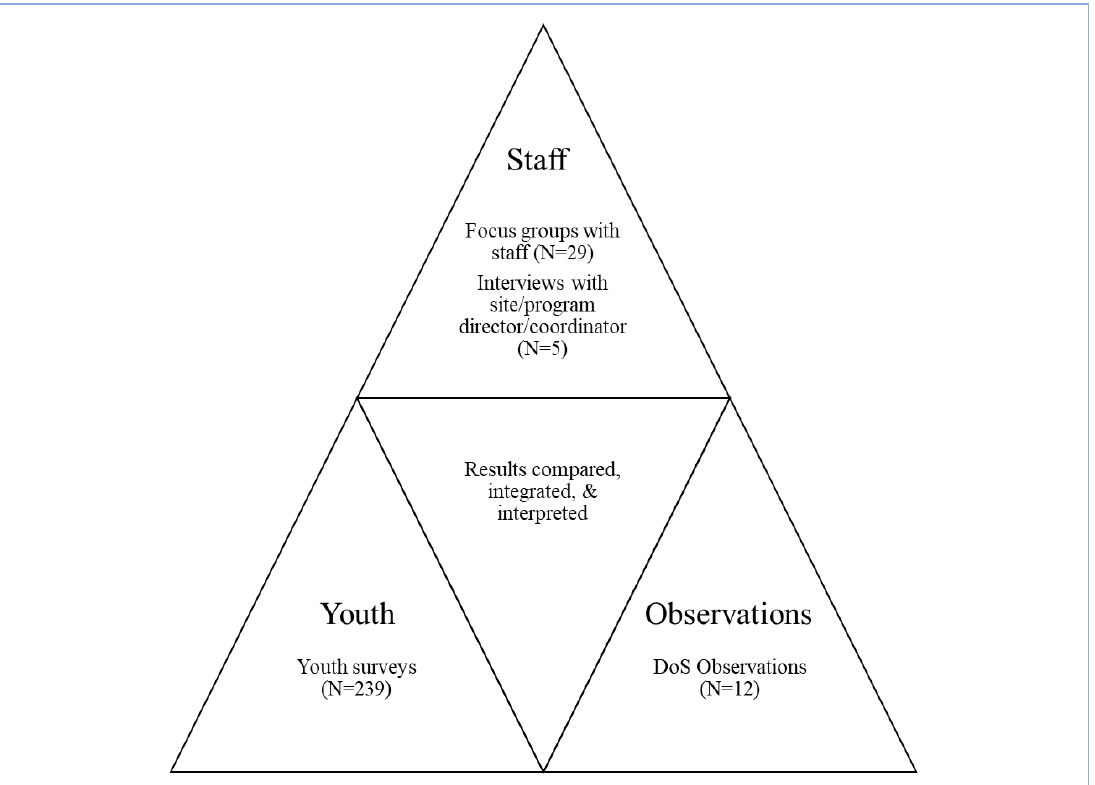
Figure 2. Diagram of Triangulation